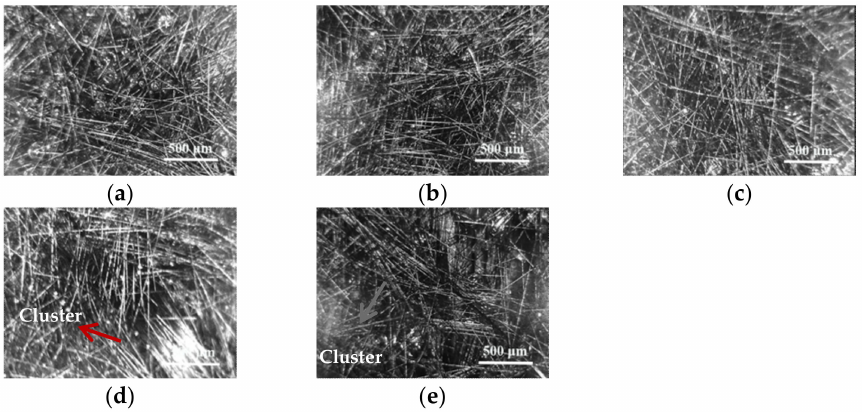
Figure 1. The distribution of 4.00 phr chopped carbon fibers with length of 2.0 mm ( a ), 4.0 mm ( b ), 6.0 mm ( c ), 8.0 mm ( d ), and 10.0 mm ( e ) in resin